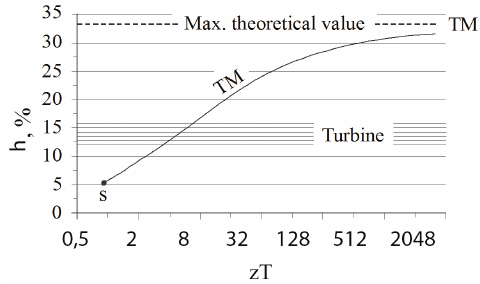
Figure 3. Comparison of the TM “efficiency” with the “binary cycle turbine” efficiency ( T